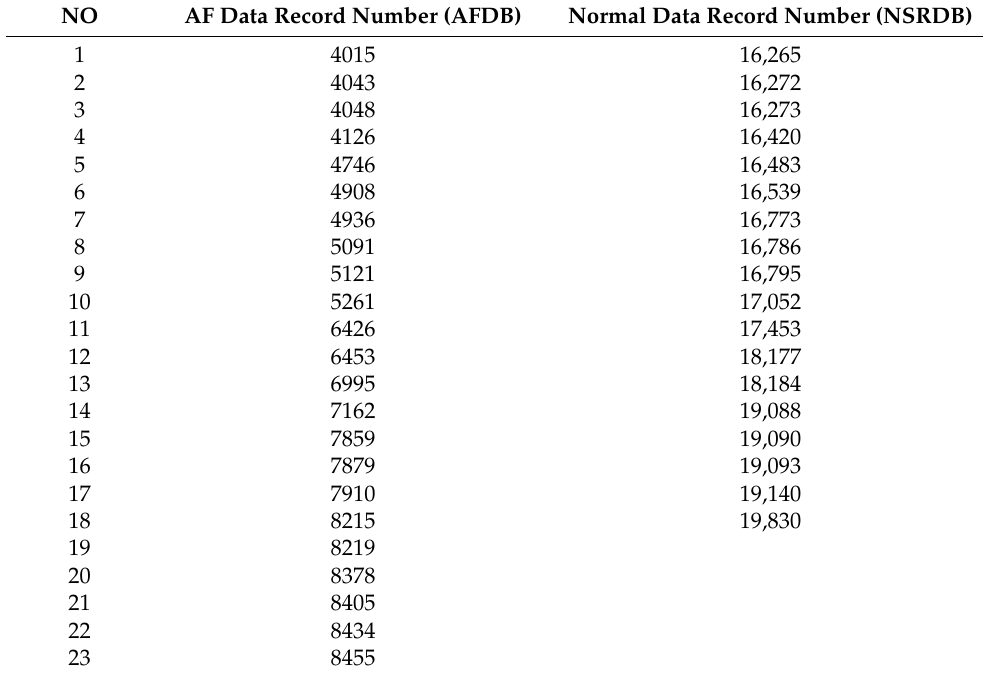
Table 1. Experimental data for detecting AF.